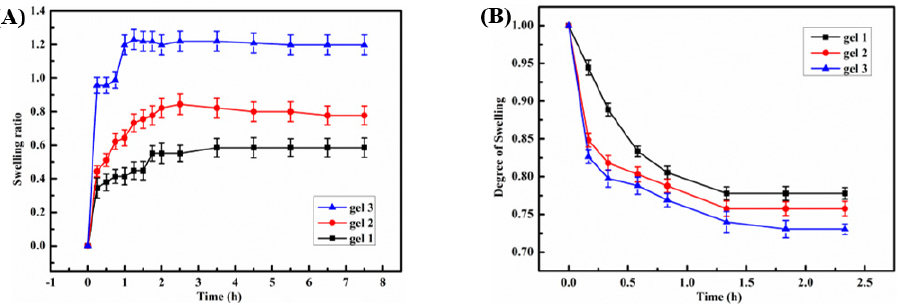
Figure 3. Swelling ratio of hydrogels at 37 °C, pH = 5 ( A ) and deswelling ratio of hydrogels at 37 °C, pH = 7.4 ( B ).